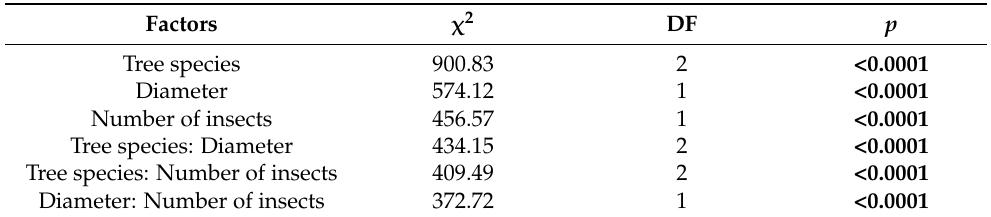
Table 3. Statistical values from the general linear model (negative binomial distribution) for the duration required to debark samples. p values considered significant (<0.05) are shown in bold.